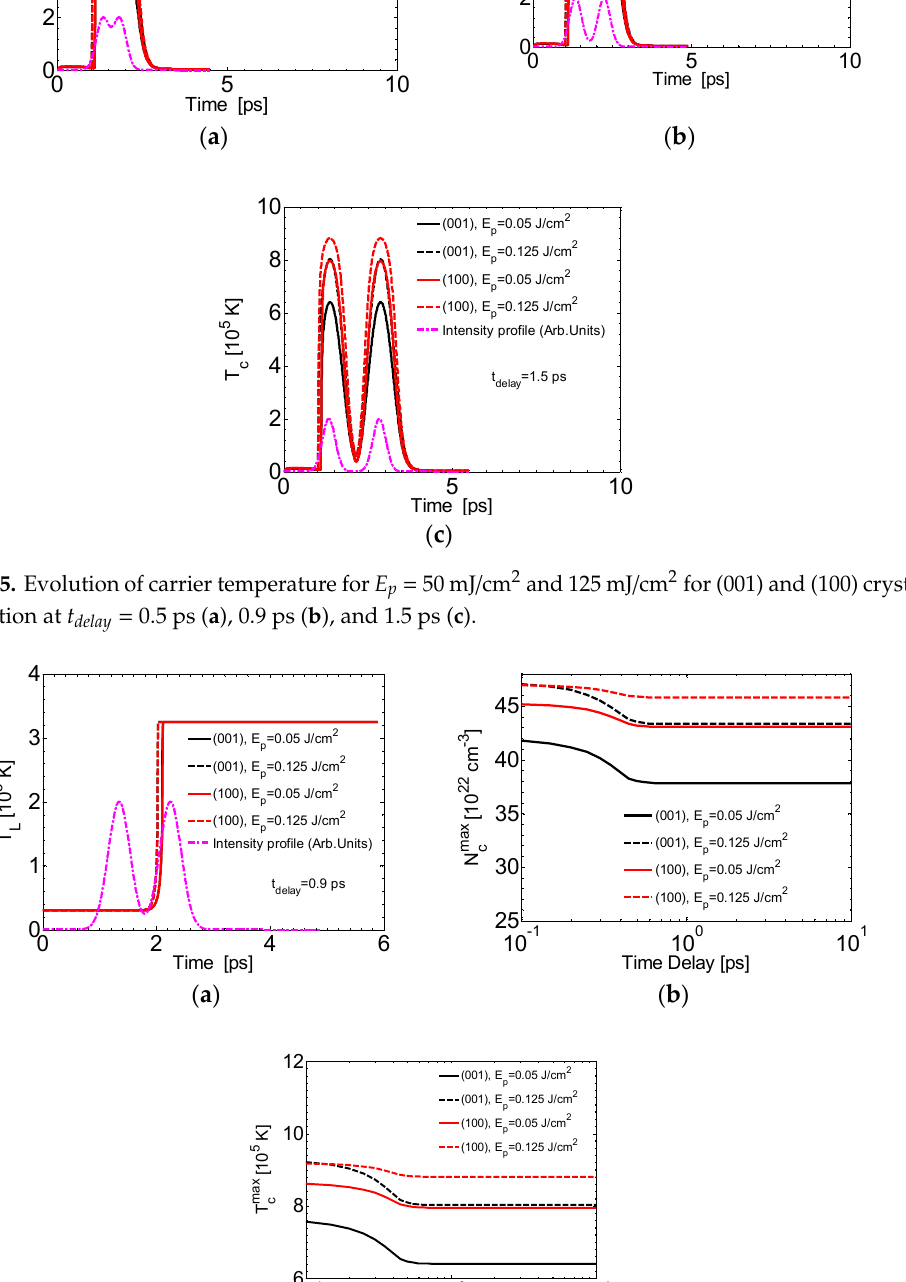
Figure 6. ( a ) Lattice temperature at t delay = 0.9 ps. ( b ) Maximum carrier density and ( c ) maximum carrier temperature for t delay in the range [0–10 ps] ( E p = 50 mJ / cm 2 and 125 mJ / cm 2 for (001) and (100) crystal